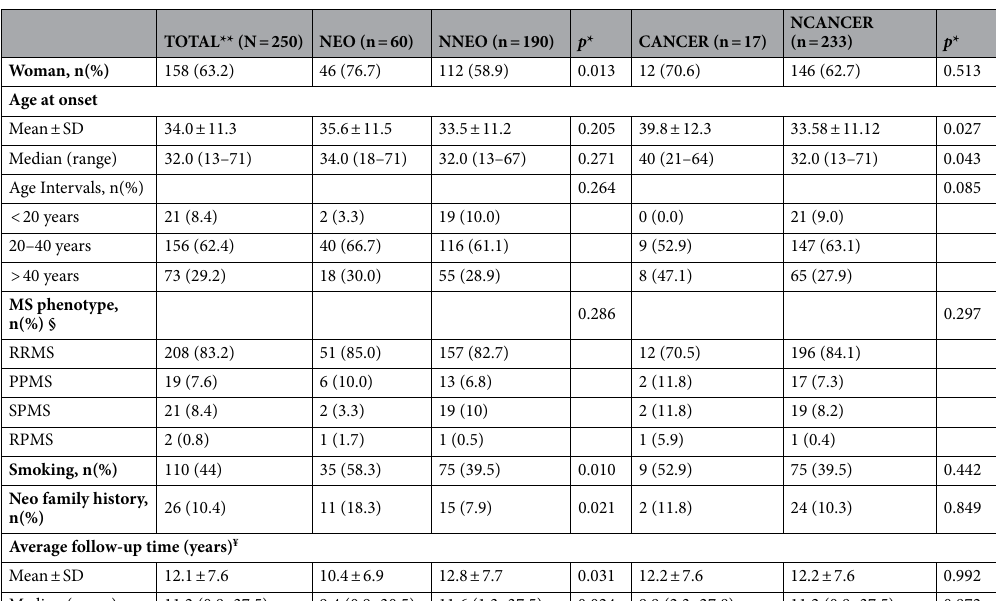
Table 1. Patient baseline features. Comparison of individuals affected vs unaffected by neoplasia. * p value from the χ -test or T-test. § RRMS: relapsing–remitting MS; PPMS: primary progressive MS; SPMS: secondary progressive MS; PRMS: progressive-relapsing MS. ¥ Time from MS diagnosis to first neoplasm/cancer appearance or end of the observation period (censored cases). **TOTAL: whole sample; NEO: patients with neoplasm; NNEO: neoplasm-free patients; CANCER: patients with cancer; NCANCER: cancer-free